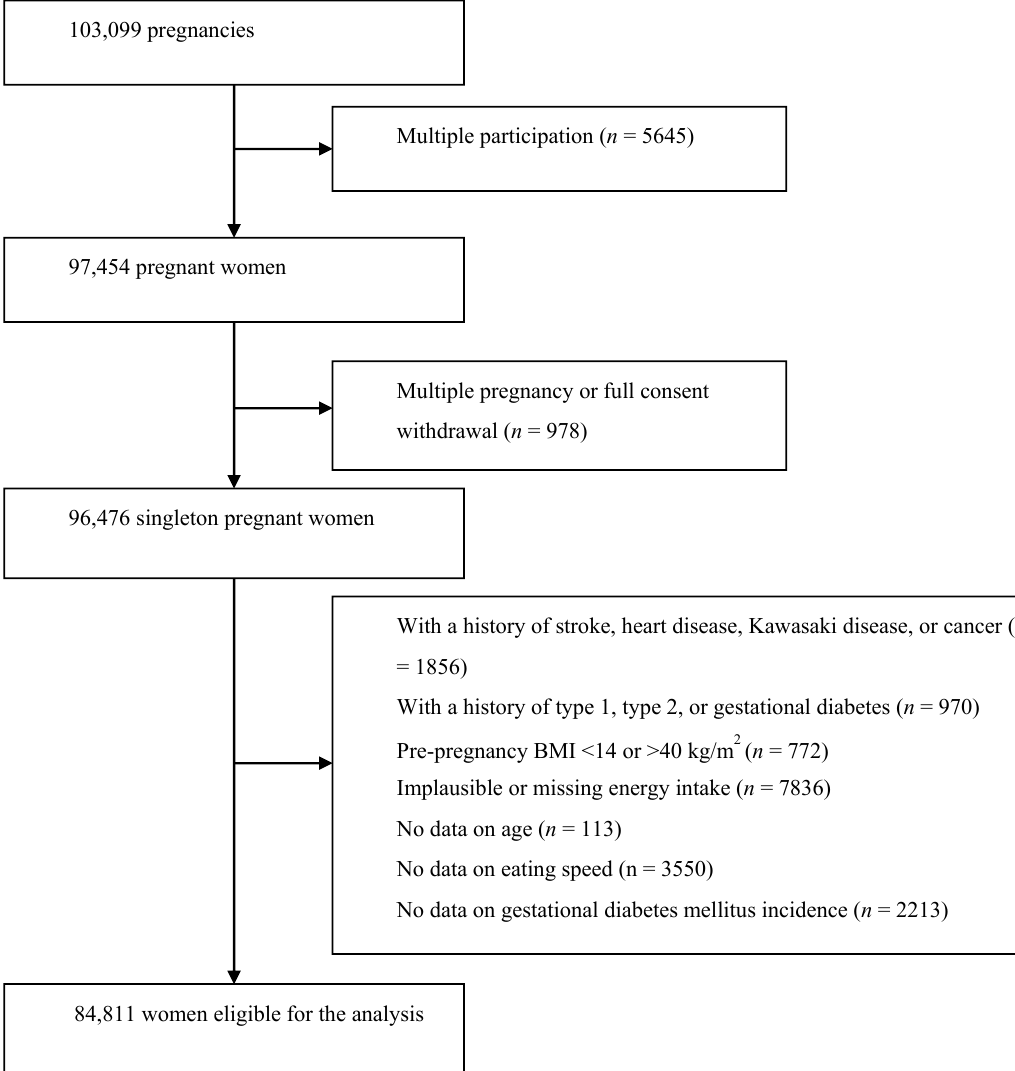
Figure 1. Flowchart for participant selection.